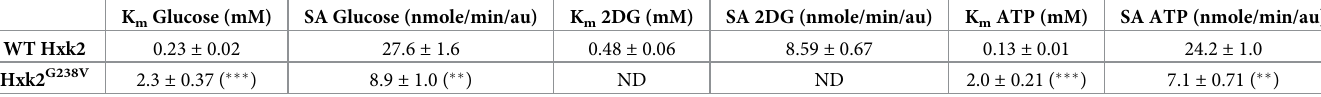
beta sheet ( β 10) near the glucose/2DG-binding site, but it does not line the site and so is unlikely to impede hexose association directly. We positioned a glucose molecule within the site by aligning a glucose-bound Sc Hxk1 structure (yeast, PDB 3B8A [8]) to 1IG8 [7]. The G238 residue is ~5.0 Å from the glucose substrate, and it participates in no apparent hydro- gen-bond, electrostatic, or hydrophobic interactions with the sugar. The G238 side chain points away from the glucose molecule, so the larger V238 side chain in Hxk2 G238V is also unlikely to interact with the bound glucose. To examine whether the amino acid at position 238 interacts with bound glucose when hexokinase is in the closed conformation—perhaps directly impeding the transfer of the γ phosphate from ATP—we examined a closed-state, glucose-bound structure of K. lactis Hxk1 (PDB 3O8M [16]). We chose this structure because there are no structures of glucose-bound S . cerevisiae Hxk2 in the Protein Data Bank [51, 52]. Fortunately, Kl Hxk1 is a good model for Sc Hxk2 [16] because the two proteins are highly homologous (73.4% amino-acid identity per Clustal Omega [53, 54], Fig C in S1 Text), have similar oligomerization [16], and are similarly phosphorylated at regulatory residue S15 [16]. In the closed-state 3O8M Kl Hxk1 structure, the bound glucose molecule is 5.8 Å from the G238-equivalent residue (also a glycine). Further- more, G238 forms no interactions with the key catalytic residue D211, nor with residues known to interact with the bound glucose (S158, K176, E269, and E302) [7]. We therefore con- clude that the G238V mutation is unlikely to impair phosphorylation by altering any of the direct interactions between Sc Hxk2 G238V and 2DG or glucose. Sc Hxk2 G238V may interfere with glucose binding by altering protein dynamics To determine whether changes in protein dynamics might explain the attenuated enzymatic activity and 2DG resistance, we performed twelve molecular dynamics (MD) simulations of Table 2. Enzyme kinetics for Hxk2 and Hxk2 G238V